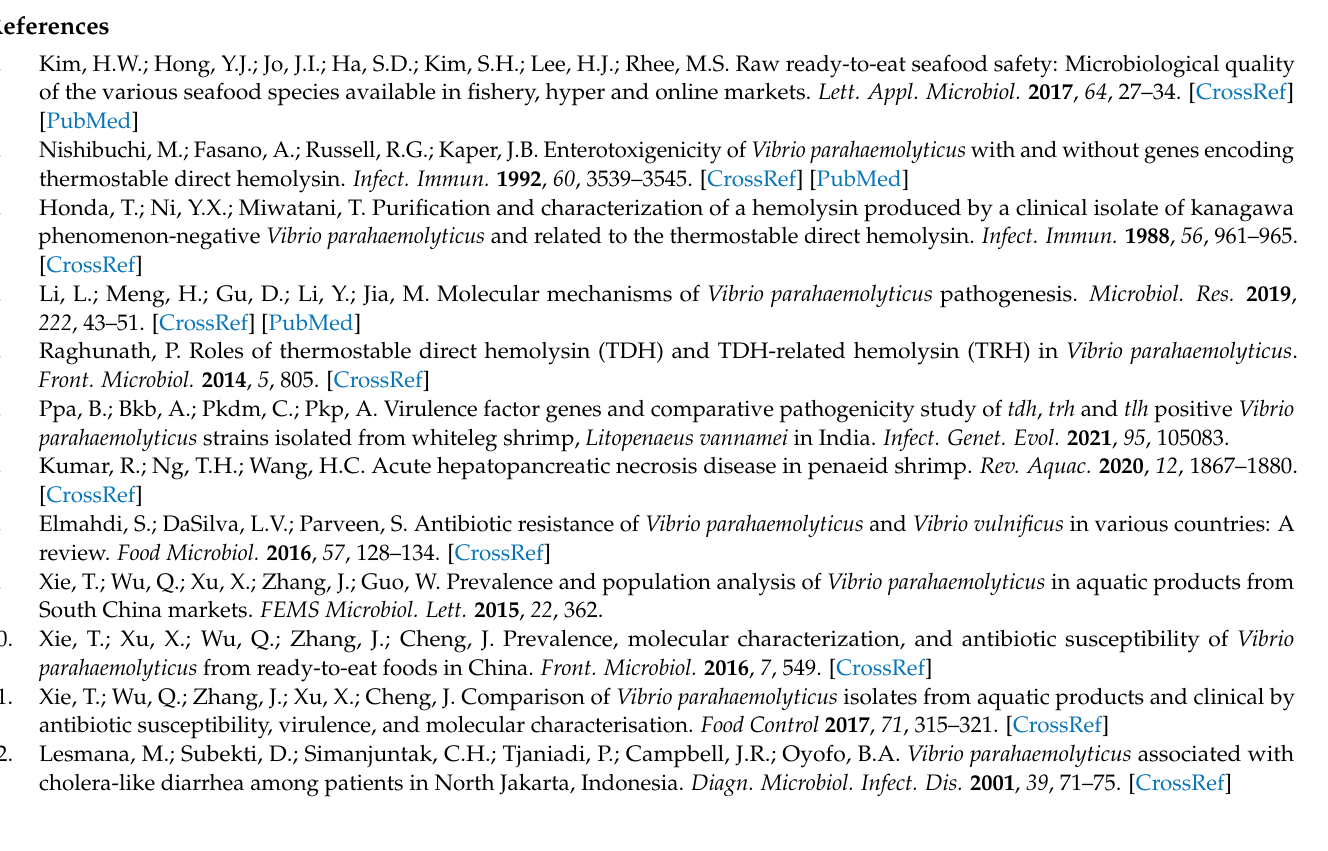
Table S3: all Vibrio phages in family Autographiviridae ; Figure S1: lysogenic validation of